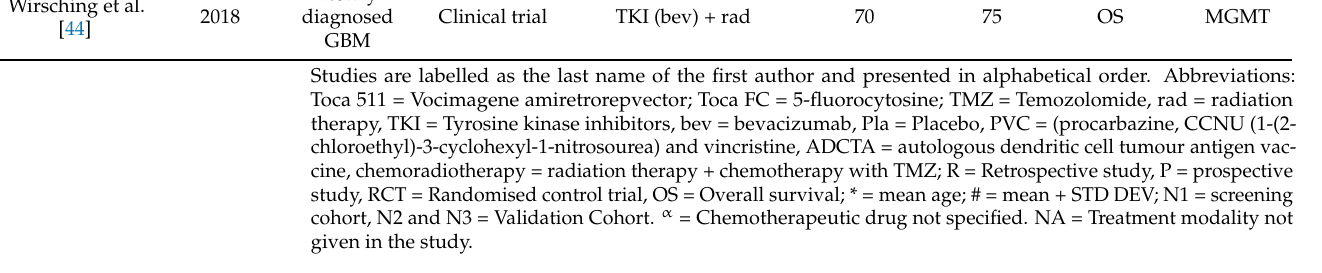
Table 2. Risk of bias